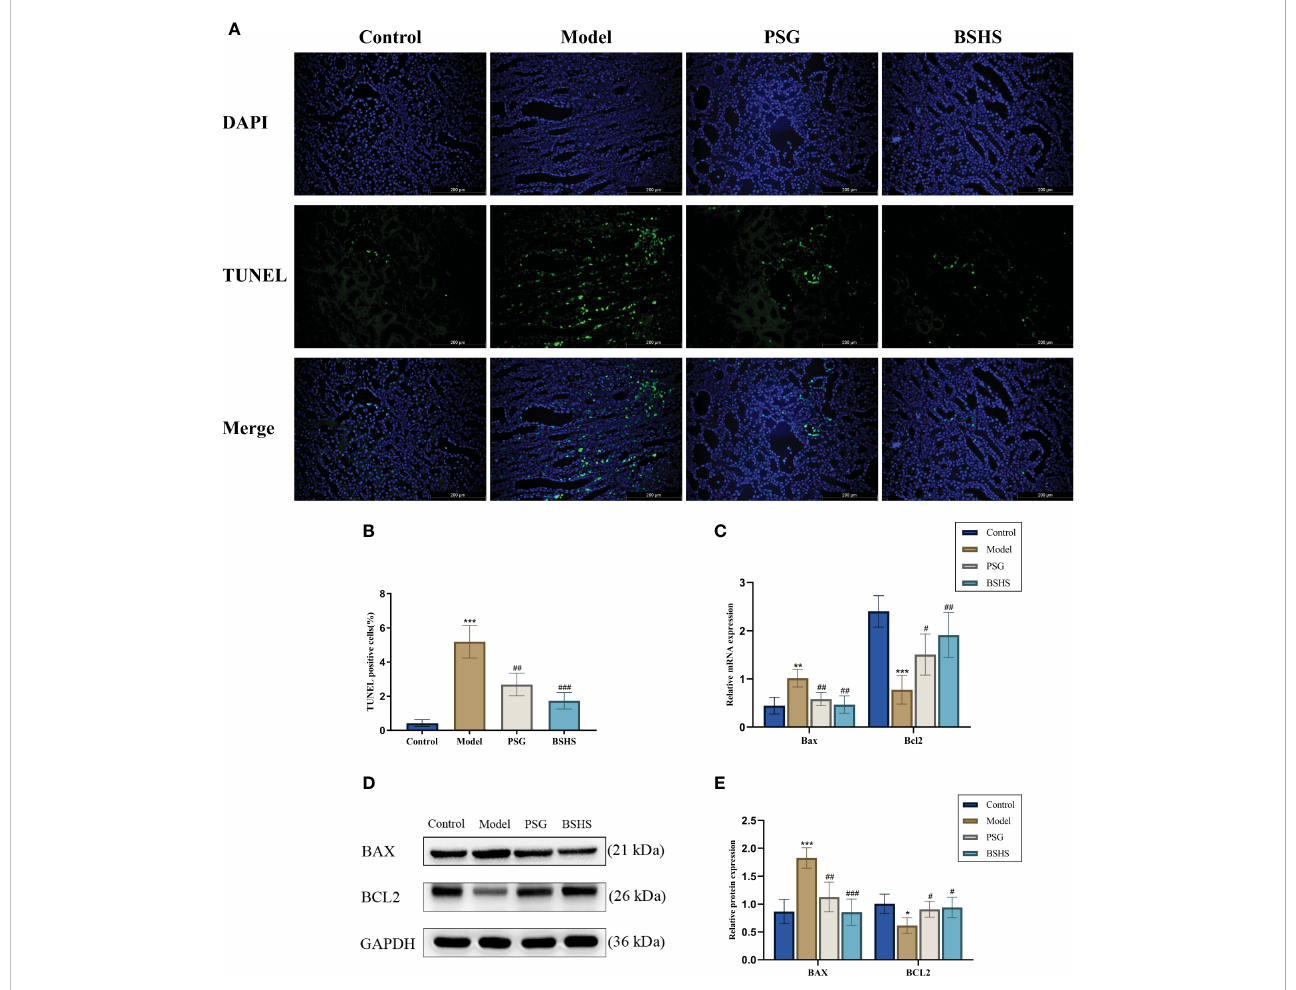
FIGURE 4 Effect of BSHS on EG+AC-induced apoptosis in rat kidney tissue. (A) TUNEL staining was used to assess renal apoptosis. (B) Images J was used to count the percentages of TUNEL-positive cells (green) to total cells (blue). (C) The expression of apoptosis-related genes was evaluated by qRT-PCR. (D) The expression of apoptosis-related proteins was evaluated by Western bolting. (E) A graph showing the semi-quantitative analysis of BAX and BCL2. Data are presented as the mean ± SD and density normalized to GAPDH. * p <0.05 vs . the normal control group, ** p < 0.01 vs . the normal control group, *** p < 0.001 vs. the normal control group, # p < 0.05 vs . the model group, ## p < 0.01 vs . the model group, ### p < 0.001 vs . the model